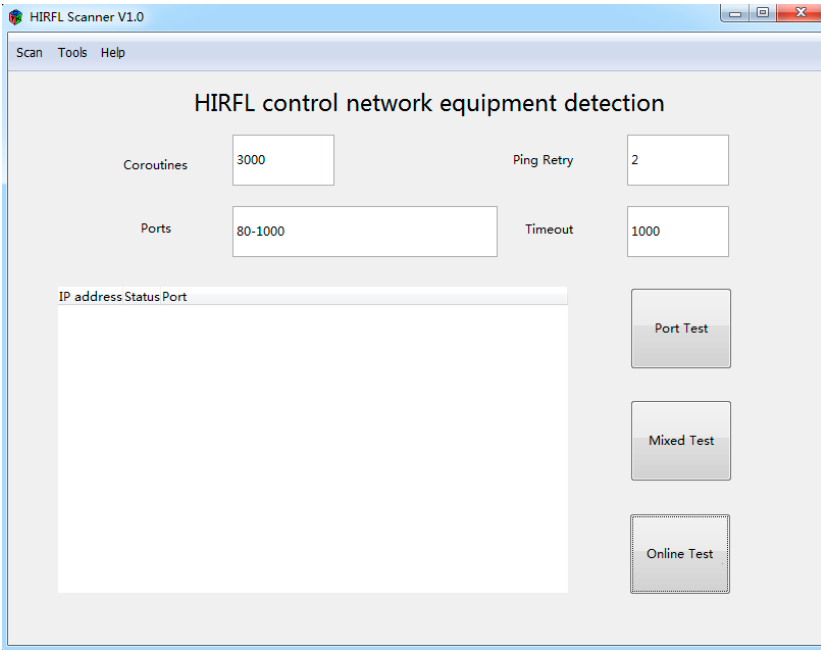
Figure 6. The HIRFL Scanner software’s main interface.